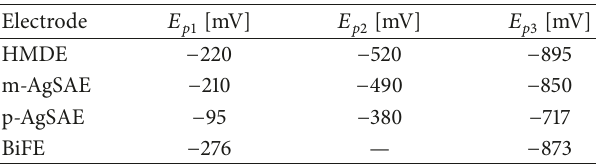
= +200 mV, 𝐸 = − 1300 mV, V in fin